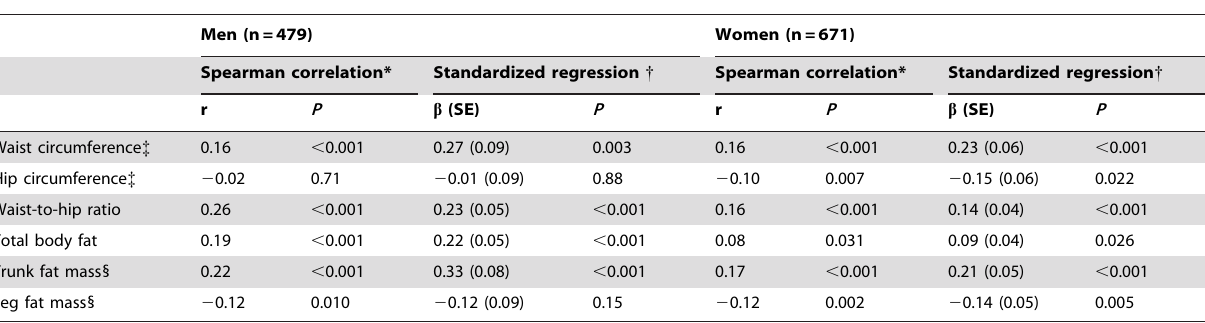
Table 2. Associations of plasma ferritin and indices of body fat distribution.